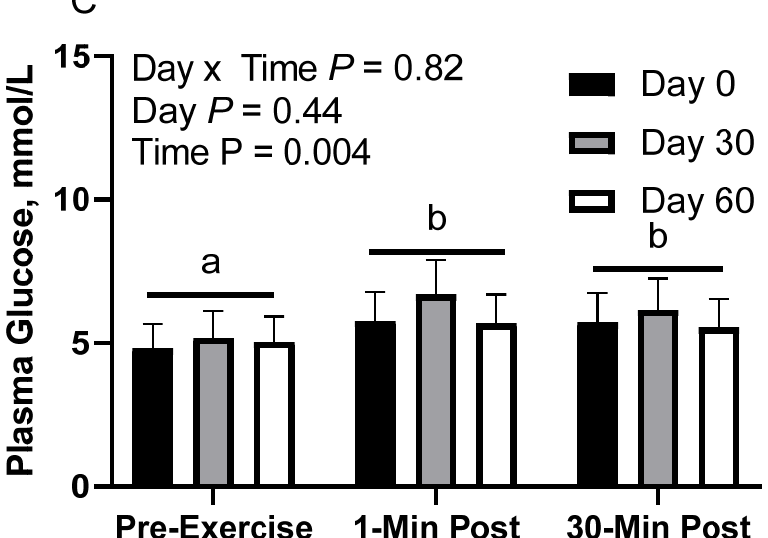
Figure 3. Geometric mean [LCI, UCI] fasting, 1 min post-exercise, and 30 min post-exercise plasma glucose concentrations in young horses fed 60% energy from hay (coastal bermudagrass) and 40% energy from concentrate (SafeChoice Original, Cargill Animal Nutrition, St. Paul, MN, USA) on d 0, 30, and 60 of a 60-day feeding trial. Where CON ( A ) did not receive dietary alteration, FLAX ( B ) had 25% of concentrate calories replaced with a flaxseed oil blend, and RICE ( C ) had 25% of concentrate calories replaced with crude rice bran oil. a,b Means not sharing a superscript differ p < 0.05. j,k Means not sharing a superscript differ p < 0.09.